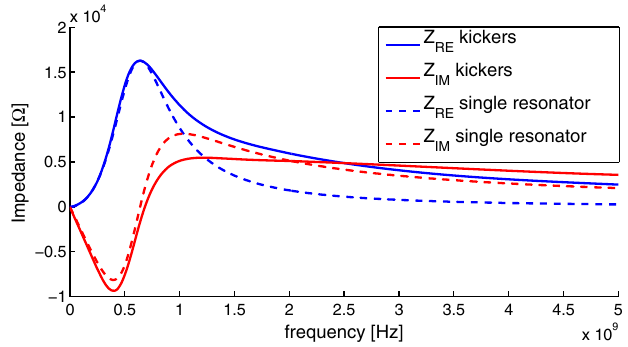
FIG. 12. Real and imaginary part of the longitudinal impedance of the PS kickers compared with a single broadband resonator.